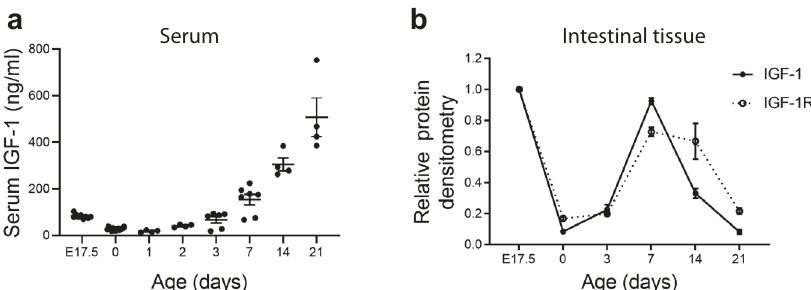
Fig. 1 Serum and intestinal IGF-1 are developmentally regulated during the perinatal period in mice. Pups from each litter were randomly assigned to different time-points. Serum and intestinal tissues were collected from mice at embryonic day 17.5 (E17.5), day of life 0, 1, 2, 3, 7, 14, and 21. a IGF-1 serum level was measured by ELISA, n = 4 – 12/time point (exact n at each time point see dots in the panels and Source Data fi le.), data represent results of three experiments combined (mean ± SEM). b Intestinal IGF-1 and IGF-1R were examined by western blot analysis. Data represent the results of